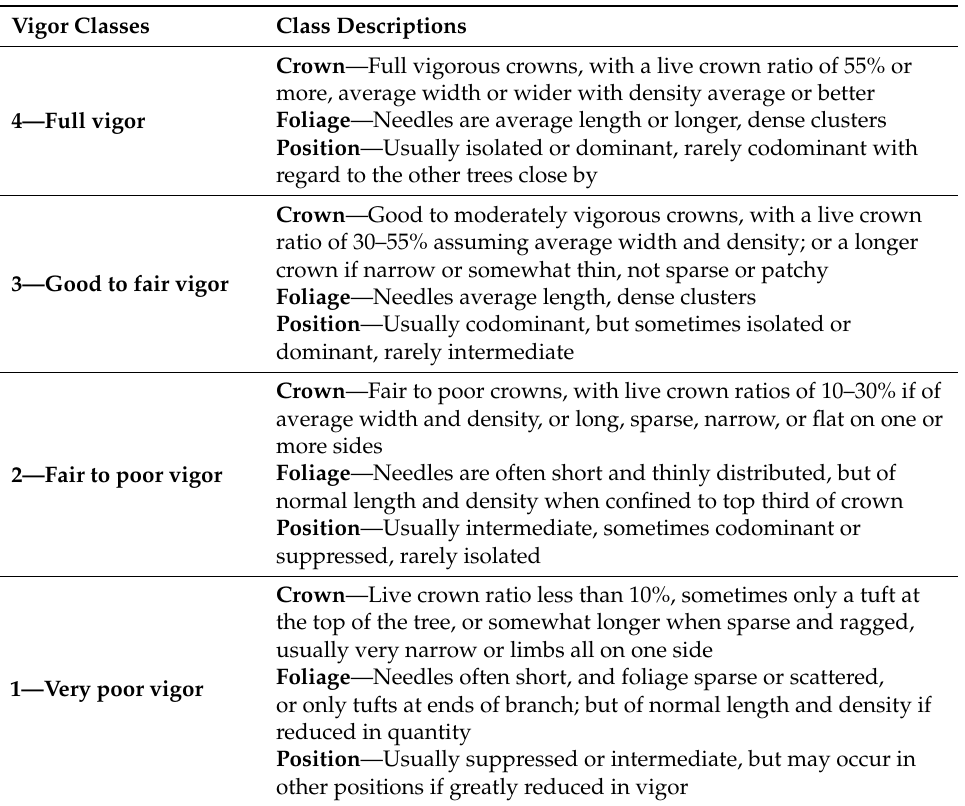
Table 2. Vigor ratings used to select sample trees. None of the sampled trees had signs of white pine blister rust or mountain pine beetle attacks. Classes were modified from the Keen (1943) rating